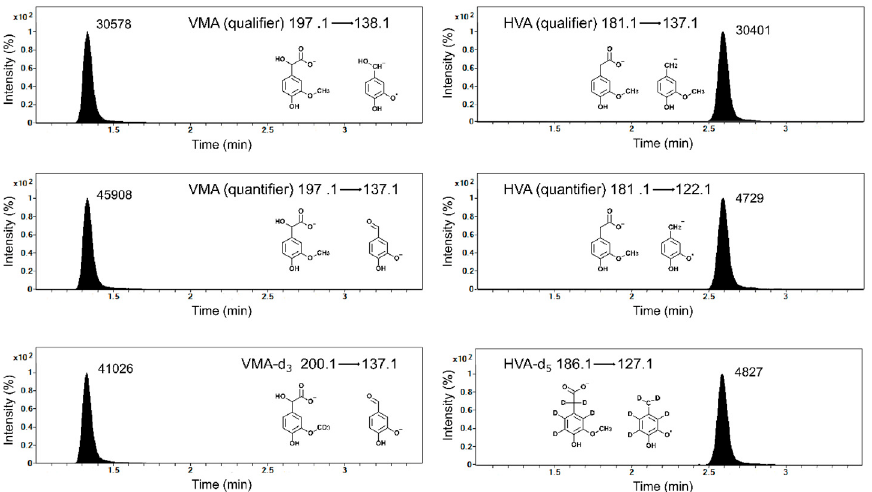
Figure 2. Representative LC–MS/MS chromatograms of blank urine spiked with HVA (10 μ g/mL), VMA (10 μ g/mL), and their internal standards (HVA-d 5 and VMA-d 3 , 5 μ g/mL).